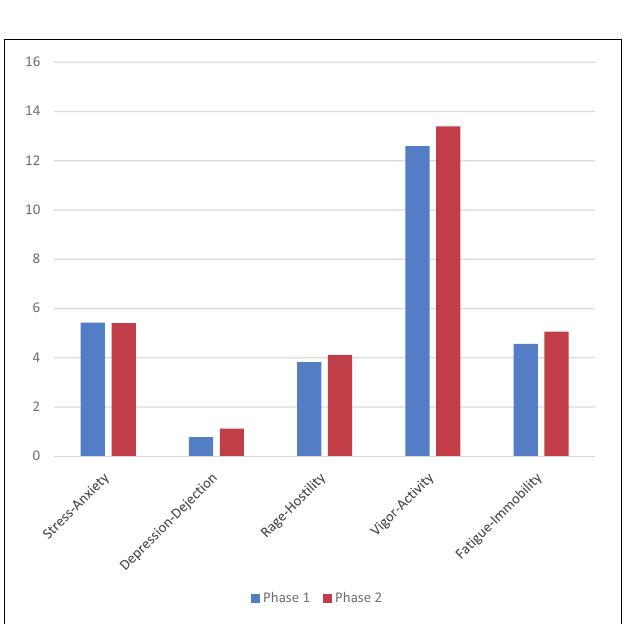
FIGURE 4 | Scores obtained on the POMS scales after the choreography, in phases 1 and 2 (2-month interval between the two): stress-anxiety; depression-dejection; rage-hostility; vigor-activity; fatigue-immobility.